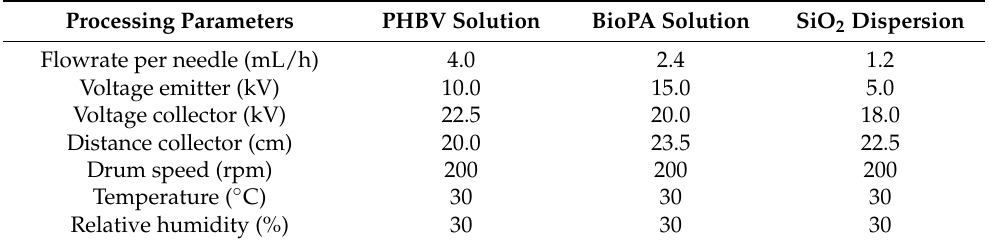
Table 3. Electrospinning parameters for PHBV and PA1010/1014 and the electrospraying of SiO 2